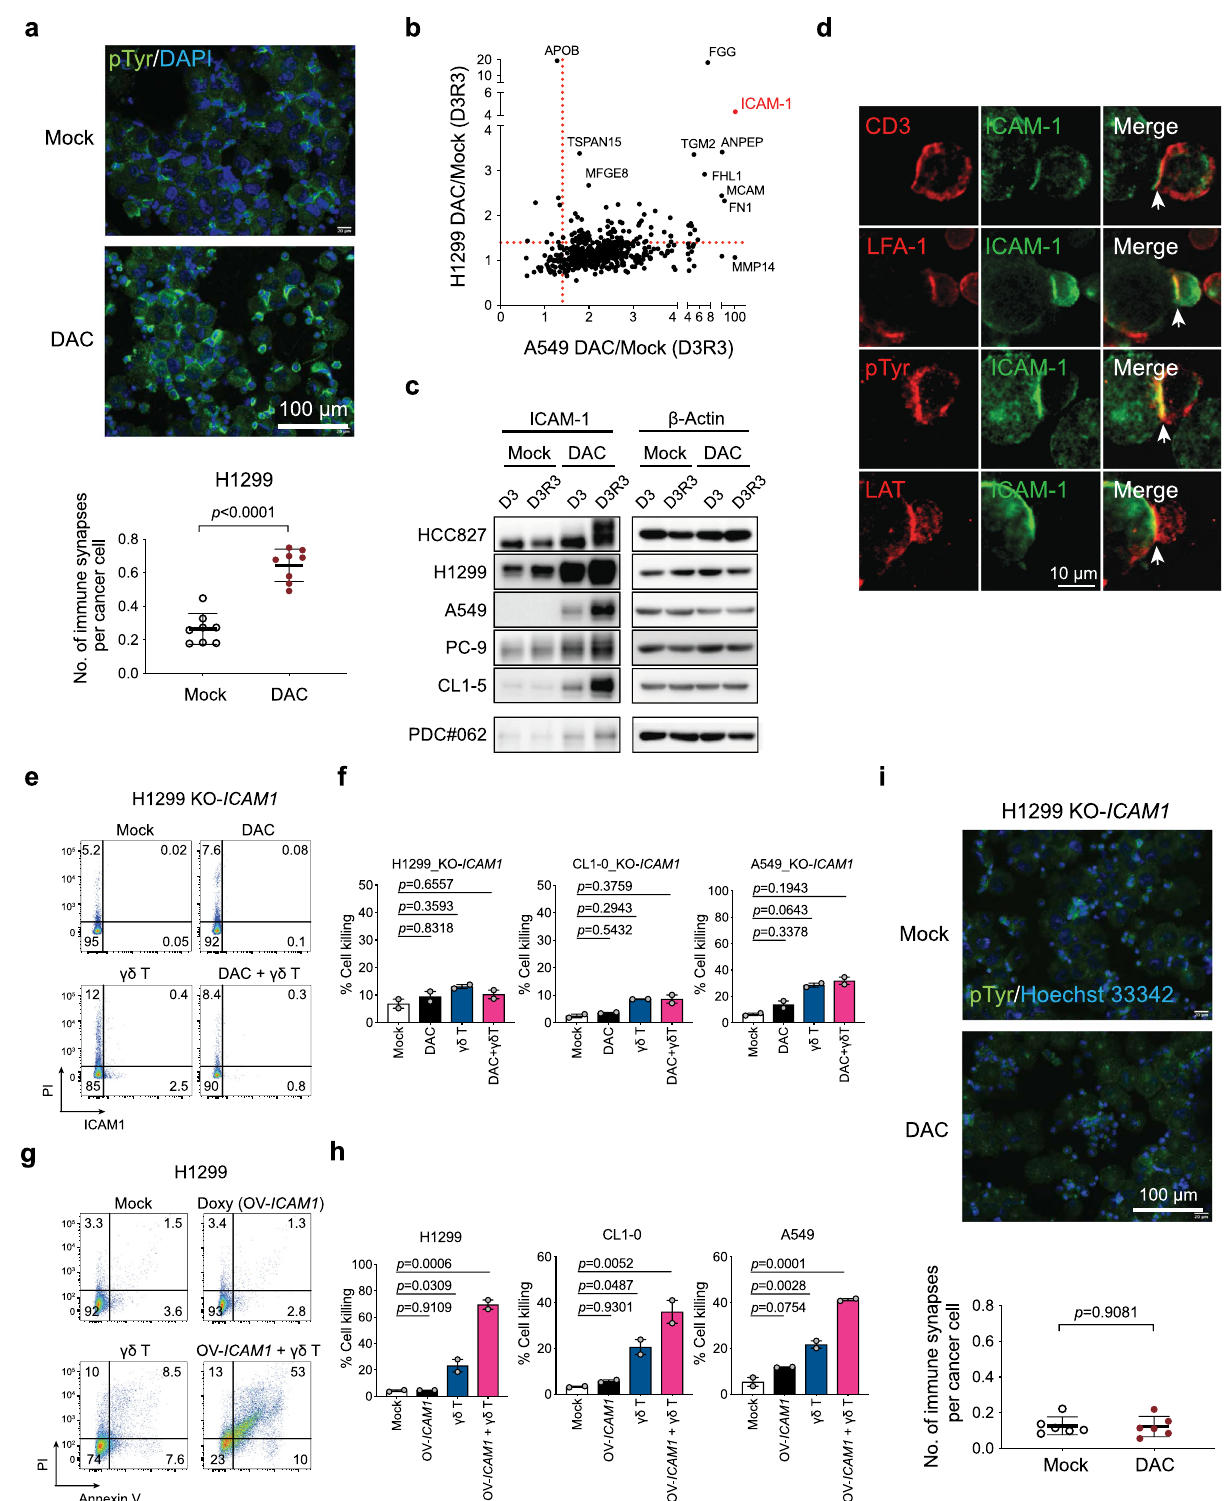
patterns can be exempli fi ed by individual genes in each of